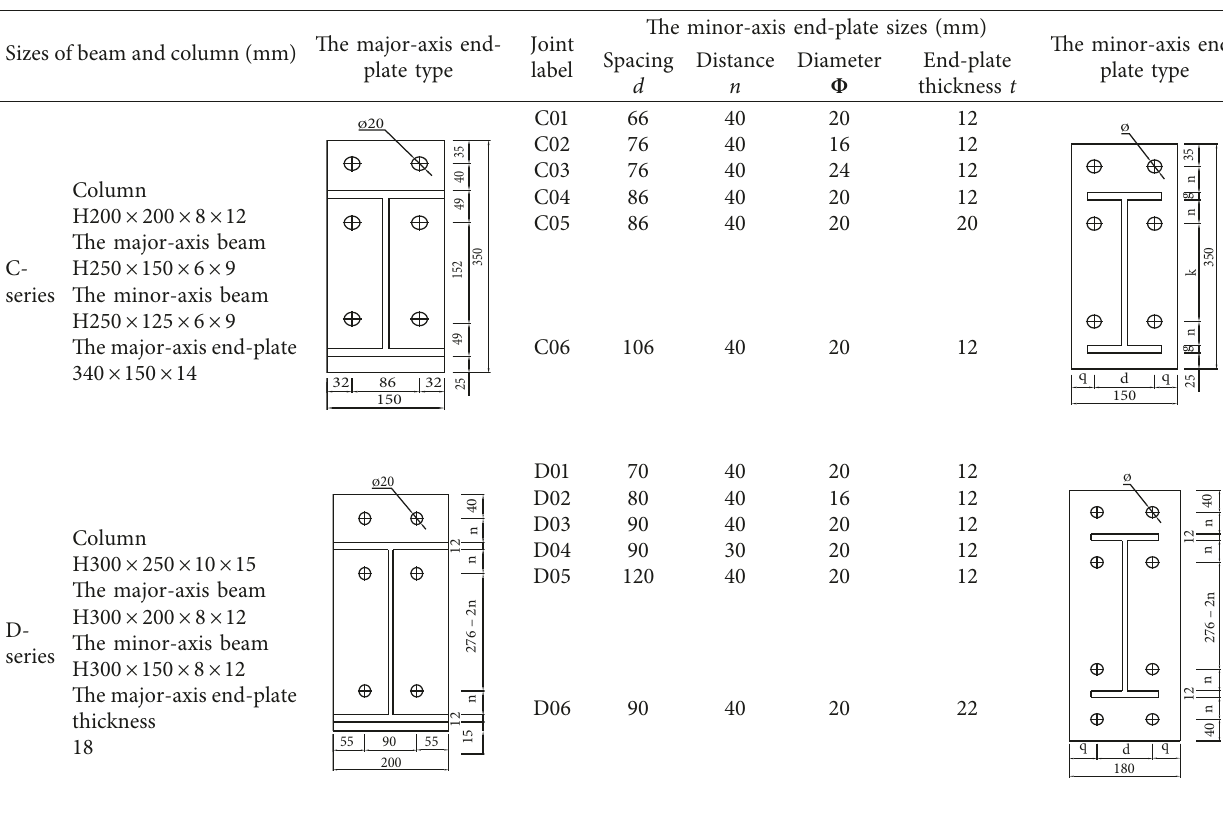
Figure 16: Calculation model of the rotation stiffness of the spatial middle column joint. Table 11: Geometric properties of the spatial